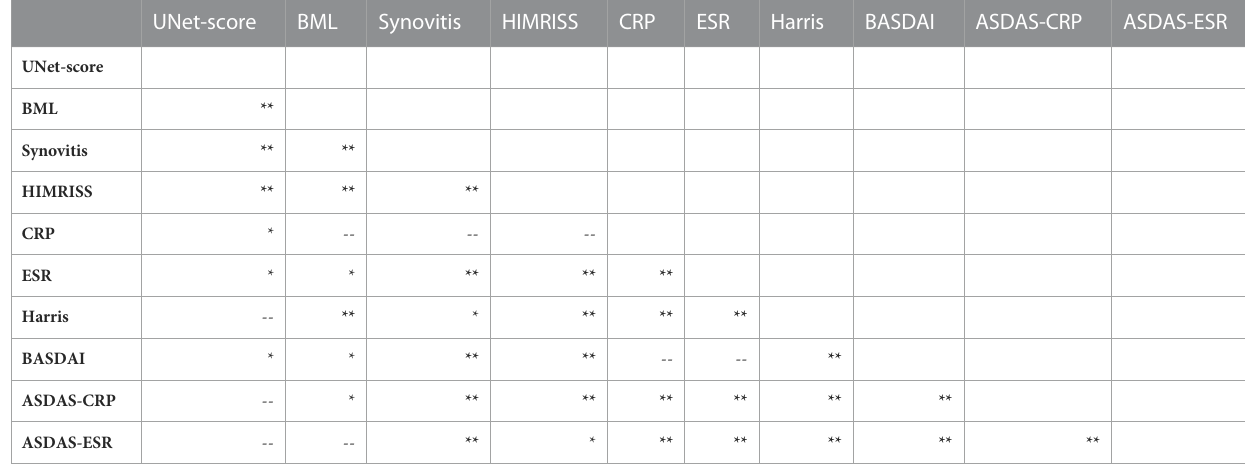
TABLE 4 Correlation between the U-Net quanti fi cation result and HIMRISS. Note, * p levels < 0.05, ** p levels < 0.01, --P levels > 0.05. Unetscore: In fl ammatory score from U-net model; ESR, erythrocyte sediment rate; CRP, C-reactive protein; BASDAI, Bath Ankylosing Spondylitis Disease Activity Index; ASDAS, Ankylosing Spondylitis Disease Activity